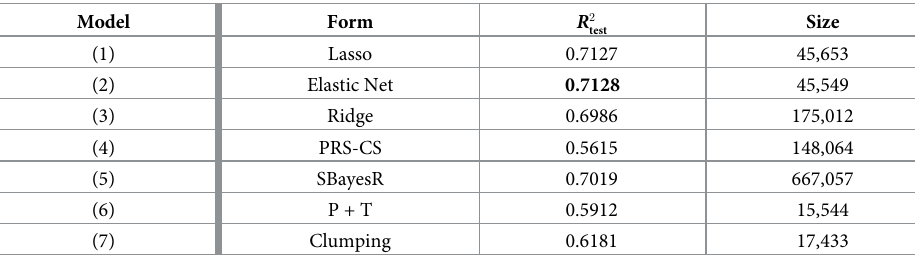
Table 3. R 2 values for height by different PRS methods with